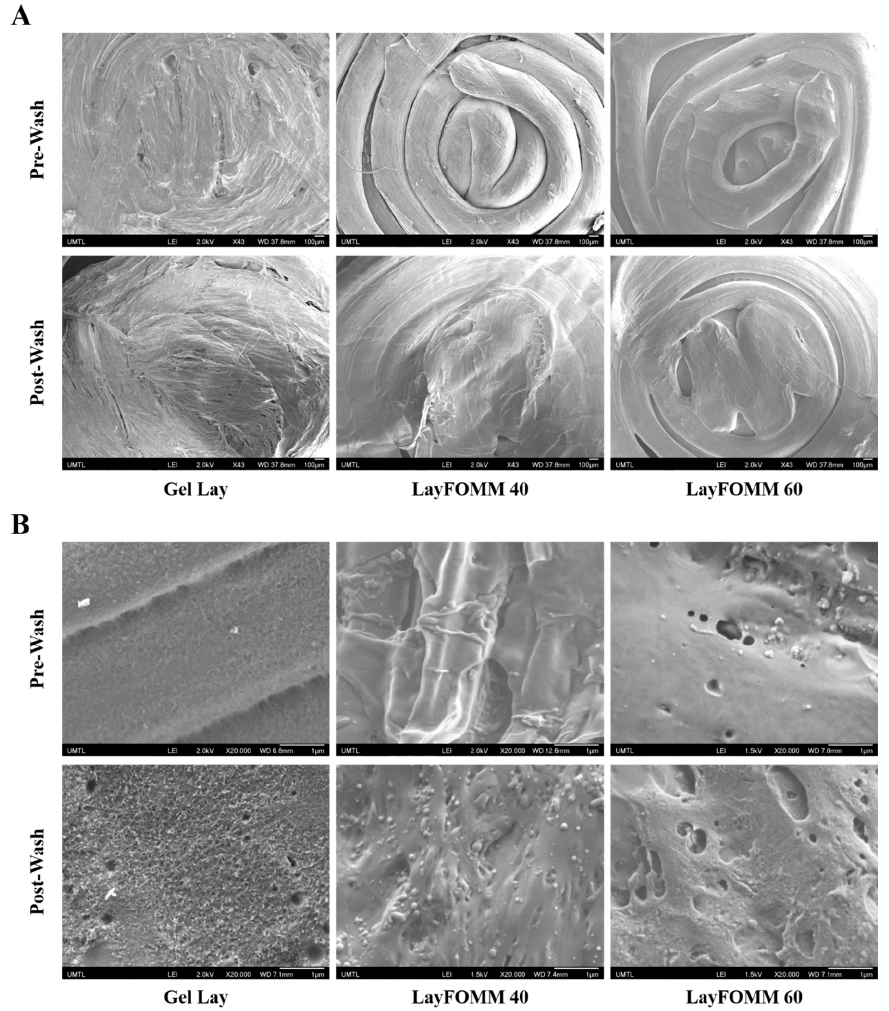
Figure 4. Electron microscope images of polymers. ( A ) 43 × magnification showing polymer surface texture before and after wash with DI water with a clear change in surface texture after wash. ( B ) 20,000× magnification showing polymer surface texture before and after wash with DI water with increased porosity noted in Gel Lay after wash.